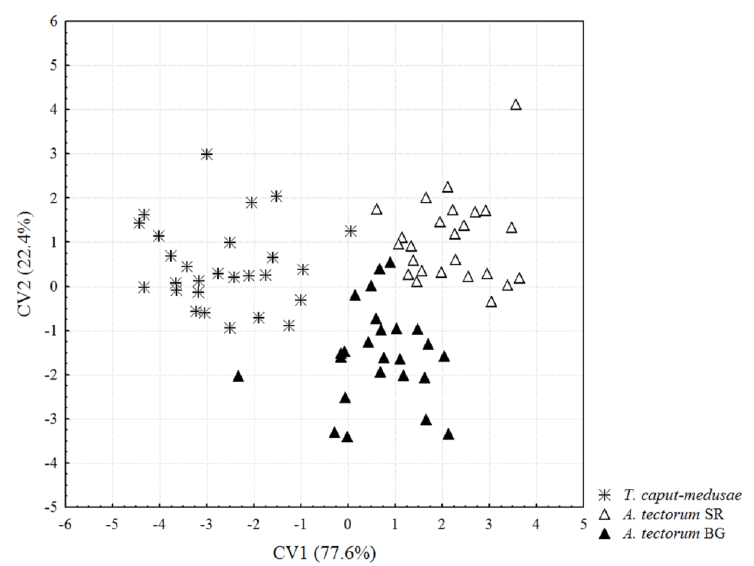
Figure 1. Canonical variate analysis (CVA) of 23 morphological traits. “ T . caput-medusae” = Aculodes altamurgiensis from Taeniatherum caput-medusae collected in Italy, “ A. tectorum SR” = Aculodes marcelli sp. nov., from Anisantha tectorum collected in Serbia, “ A. tectorum BG” = Aculodes marcelli sp. nov., from A. tectorum collected in Bulgaria. Table 2. Standardized coefficients for canonical variables on the first two (CV1 and CV2) canonical axes (Cum. Prop. = cumulative proportion of described differences between mite populations. Morphological characters that contribute most to the separation of mite populations are marked in bold).